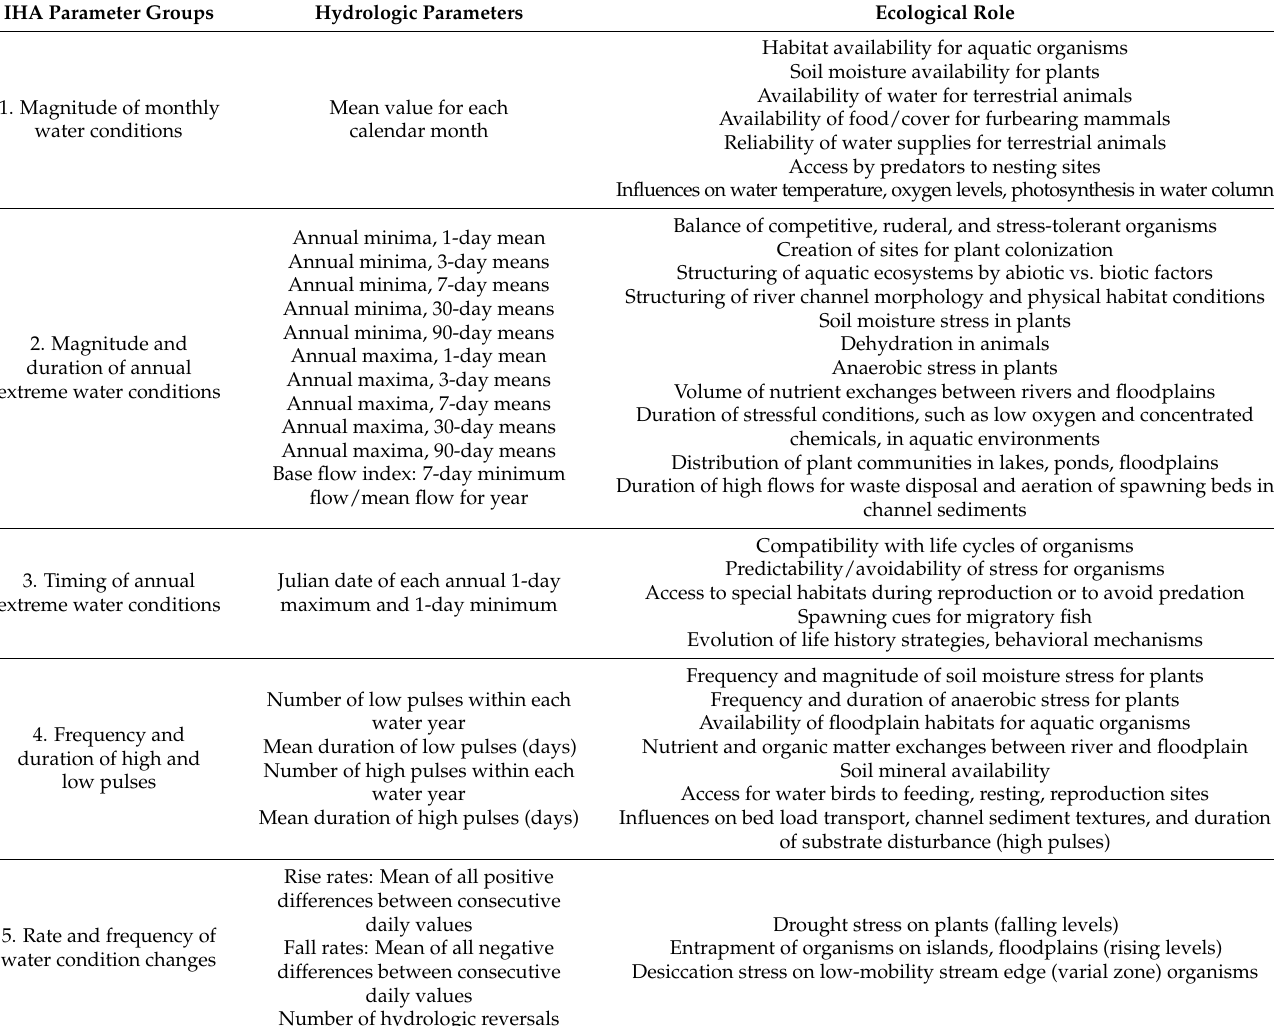
Table 3. Analyzed IHA parameters and their role in the ecosystem (adapted from the IHA manual [39]). IHA Parameter